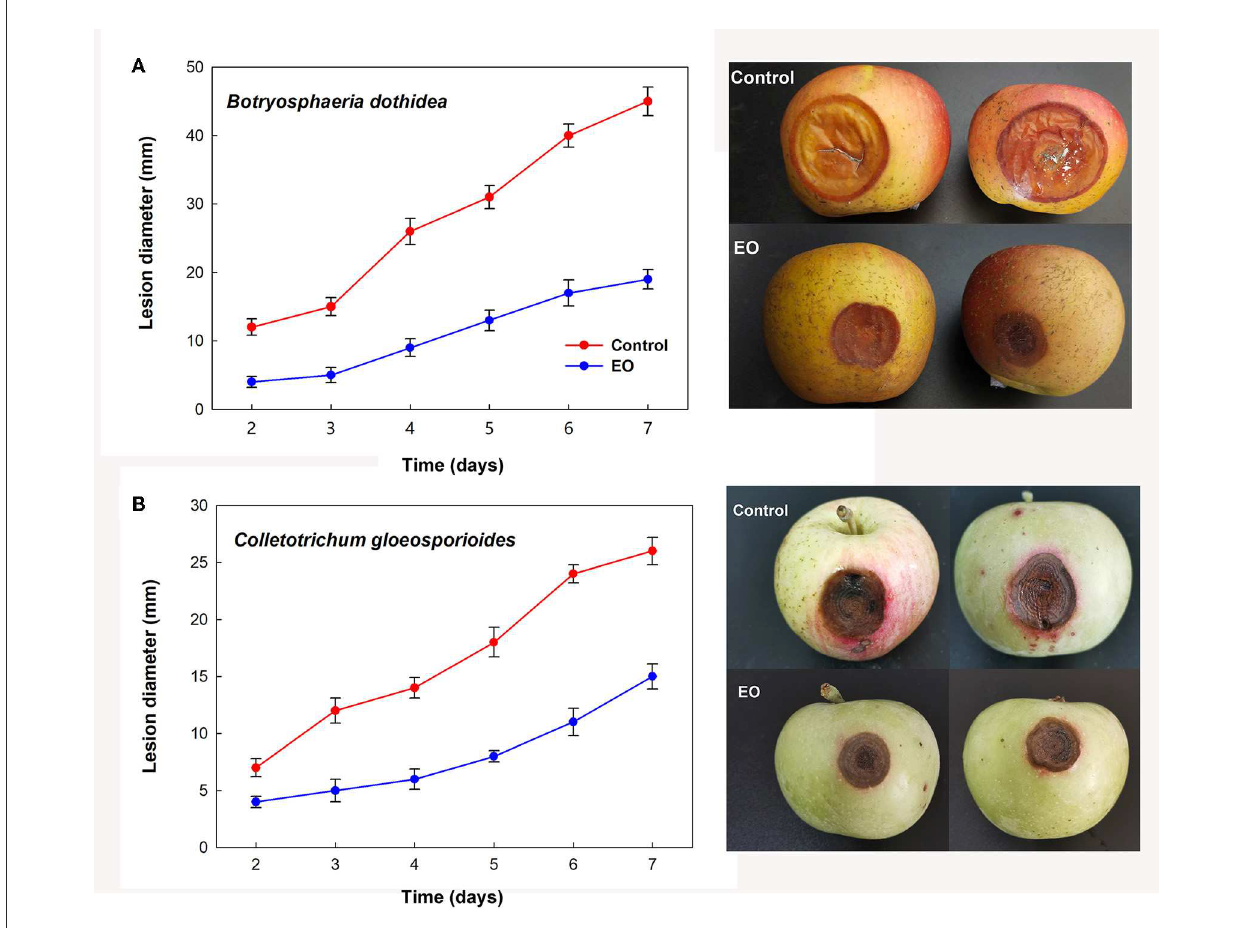
FIGURE4 Controlling effect of cinnamon and clove EO on mold rot caused by B. dothidea (A) and C. gloeosporioides (B) in bagging-free apple. Bar represents the standard deviation of the means of three independent experiments. Lesions in apple fruit are also shown after 7 days of storage at 25 ◦ C.